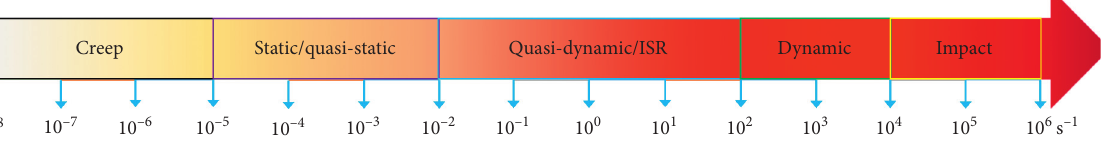
Figure 1: Stress state of rocks under different strain